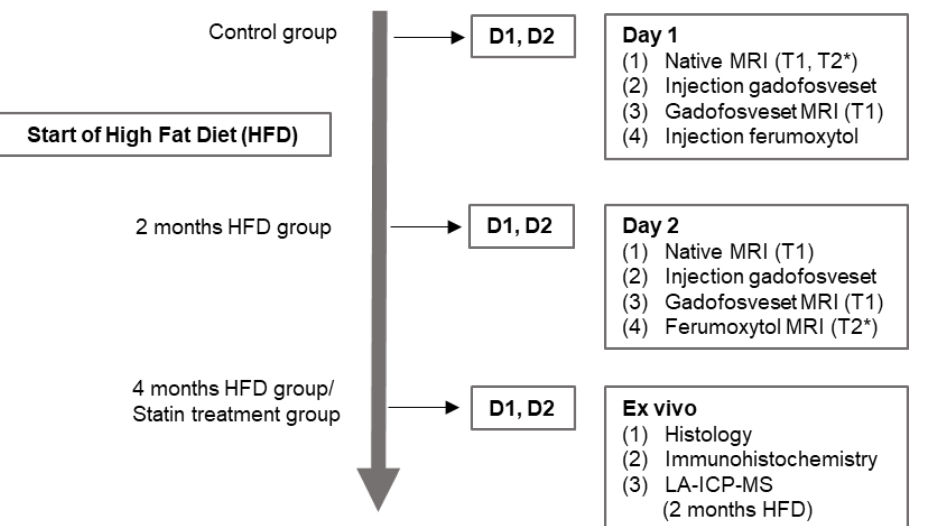
Figure 1. Overview of the experimental design. On day one, the mice underwent a pre-contrast MRI examination including T1- and T2*-weighted sequences. After injection of gadofosveset at a clinical dose of 0.03 mmol/kg, a T1-weighted MRI scan was performed. Subsequently, ferumoxytol was administered at a dose of 4 mg Fe/kg. On day two, an unenhanced (native) T1-weighted MRI sequence was acquired to prove the absence of any residues of gadofosveset. After the second injection of gadofosveset, T1-weighted and subsequent T2*-weighted MRI sequences were acquired. Thereafter, different ex vivo examinations of the brachiocephalic tissue were performed.